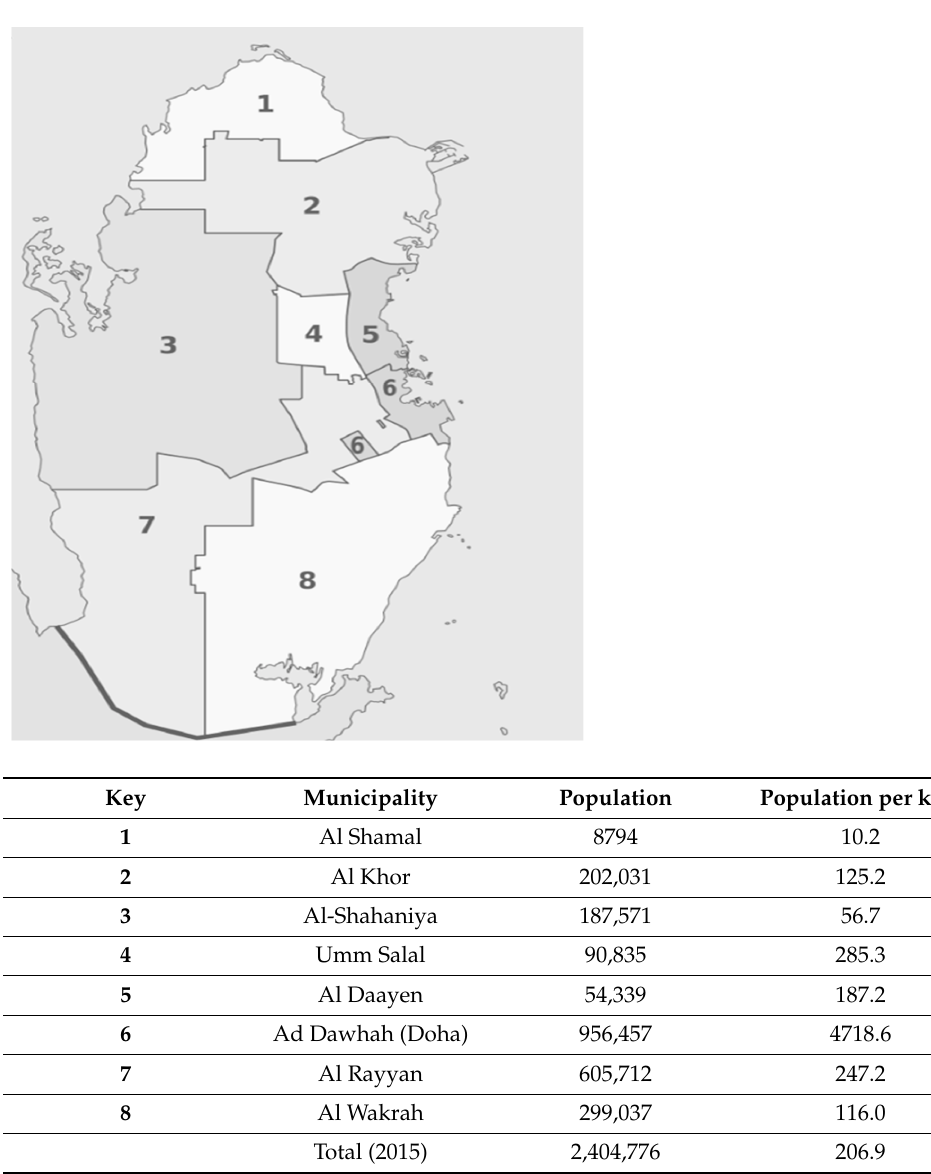
Figure 1. Map of the eight municipalities of Qatar in